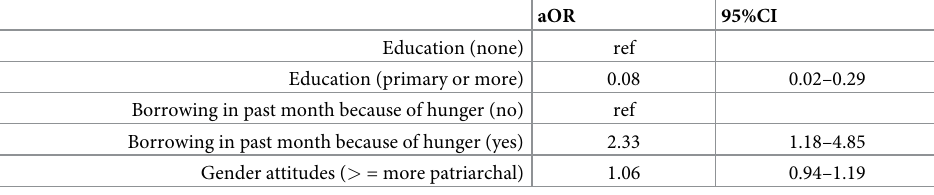
Table 6. Factors associated with ‘honour killing’ amongst unmarried women in the occupied Palestinian Territo- ries (n =